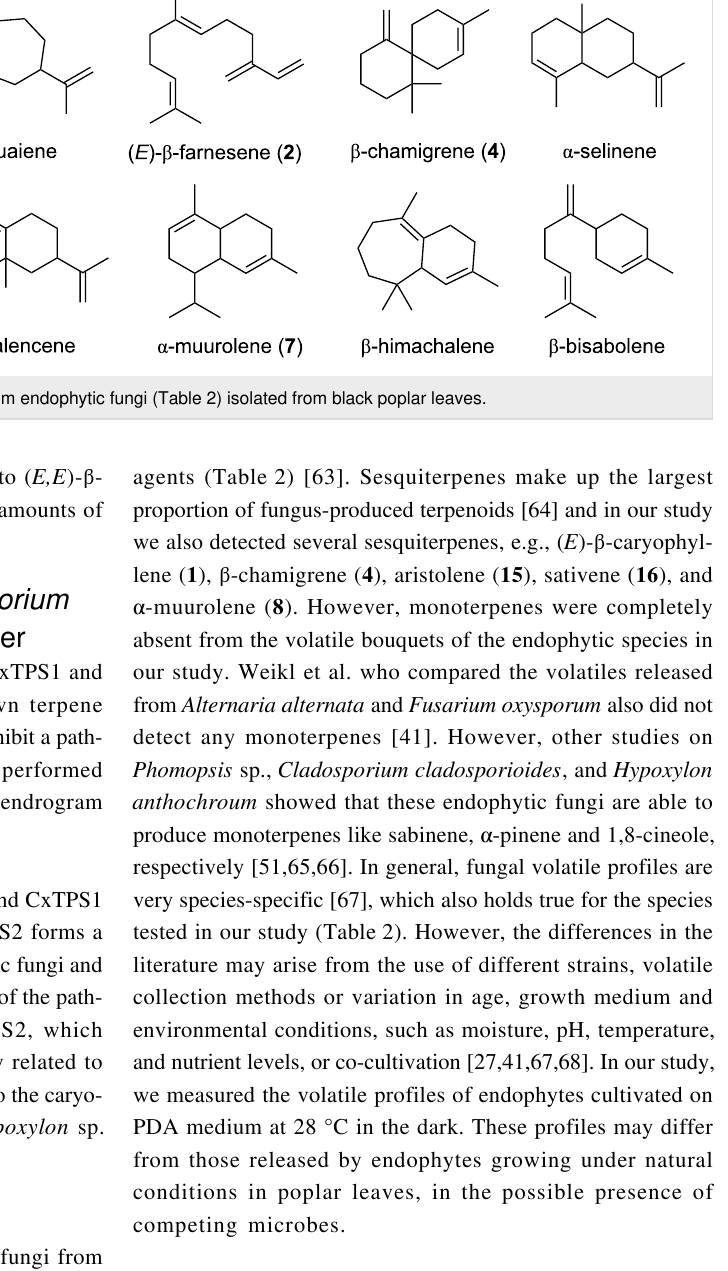
Figure 1: Chemical structures of sesquiterpenes emitted from endophytic fungi (Table 2) isolated from black poplar leaves.